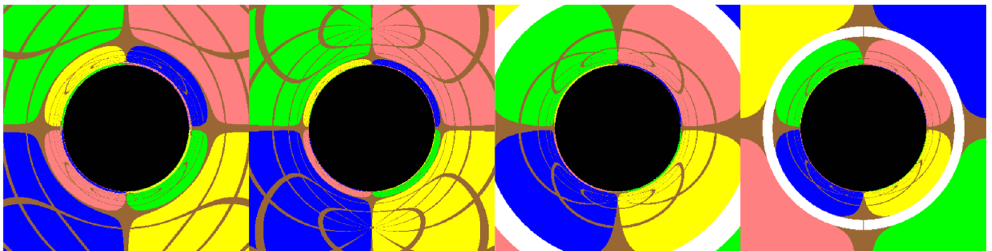
Figure 1 . The change of black hole shadow with the coupling constant α for the metric (2.22). Here we set the black hole M = 1 and rotation parameter a = 0, and the observer locates in the position with r obs = 50 M and θ obs = π/ 2. The figures from left to right correspond to α = 0 . 2, 0, and 0 . 2, −